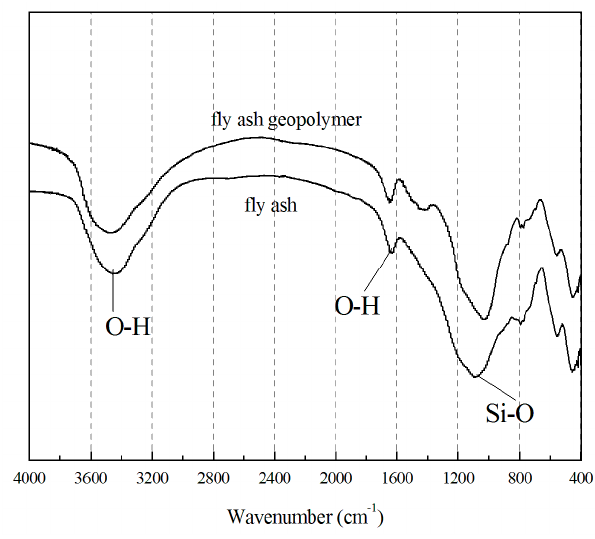
Figure 10. FTIR spectra of raw fly ash and geopolymeric lightweight concretes.